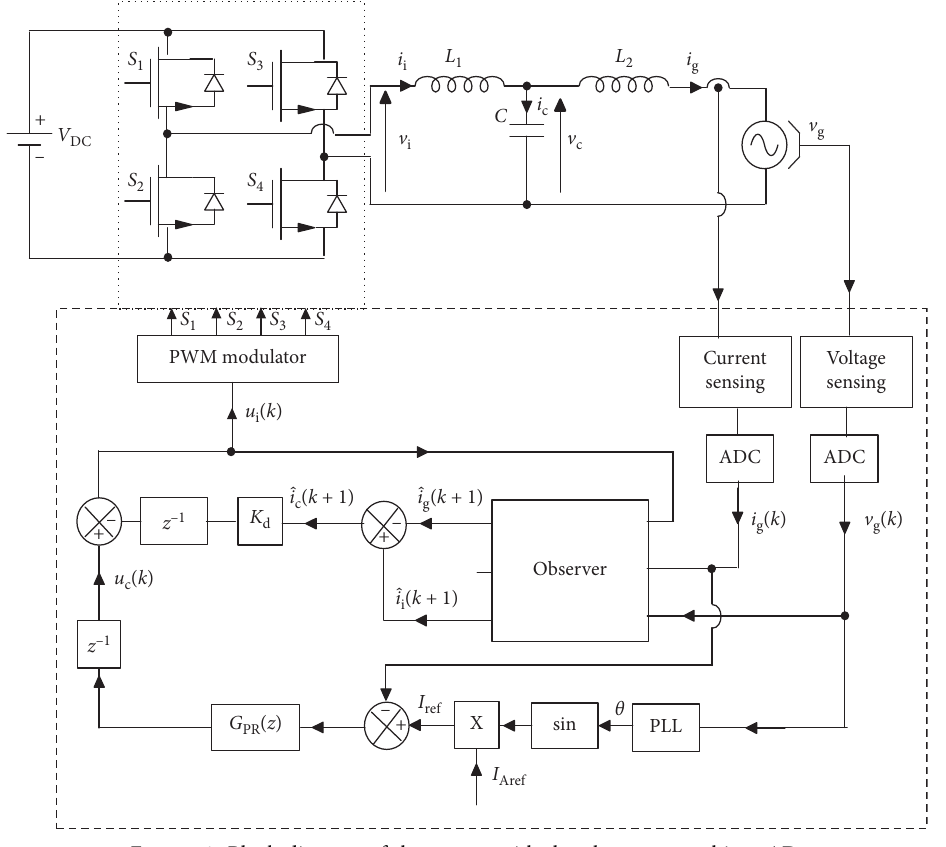
Figure 9: Block diagram of the system with the observer to achieve